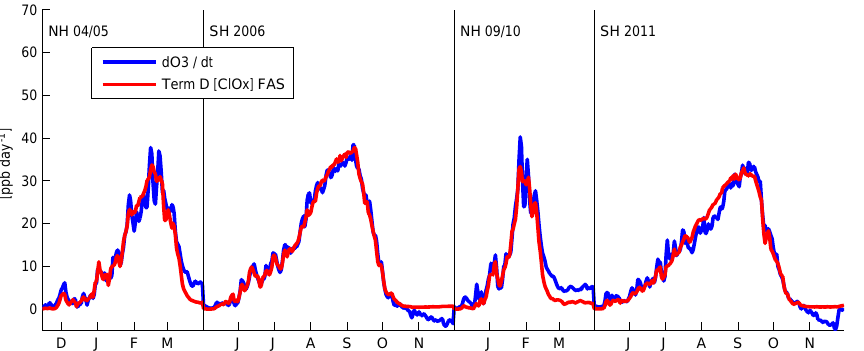
Figure 14. Fit of term D for the Arctic winter 2004/2005, the Antarctic winter 2006, the Arctic winter 2009/2010 and the Antarctic win- ter 2011 at 54hPa. Vortex-averaged rate of change of O 3 by all reactions modeled by ATLAS (blue) and the fitted term D (red). Tick marks on the horizontal axis show start of months.